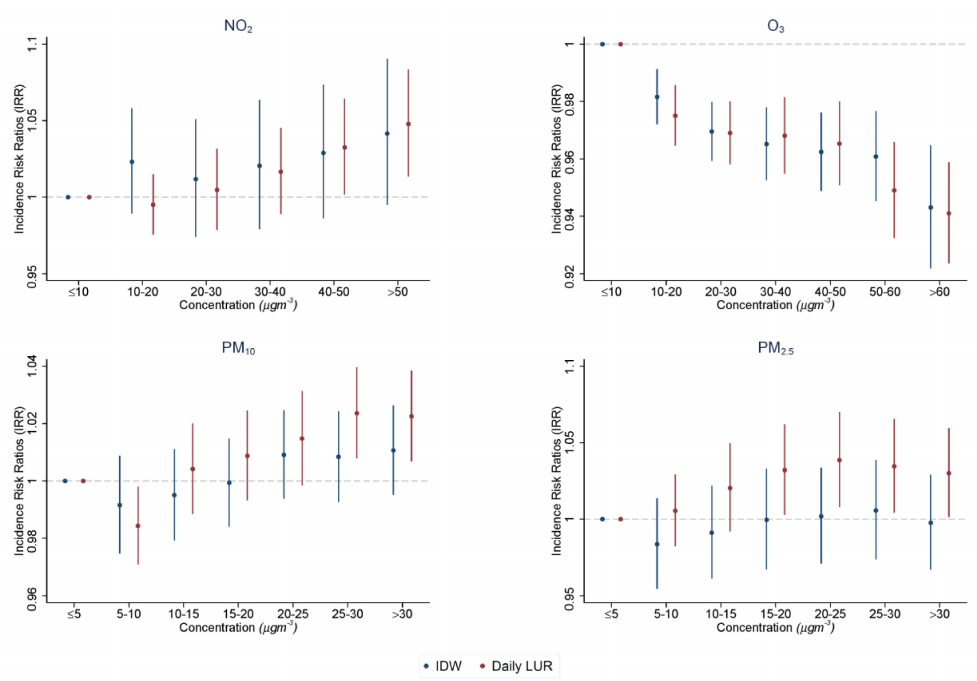
Figure 4. Incidence risk ratios (IRRs) of the effect of exposure on a day in a given range of each pollutant, relative to a day in the reference group. This represents the contemporaneous effect of each pollutant ( β p ). For PM 2.5 and PM 10 , estimates are shown across 5 µgm − 3 bands with a reference group in the 0–5 µgm − 3 range. For NO 2 and O 3 , estimates are shown across 10 µgm − 3 bands with a reference group in the 0–10 µgm − 3 range. Each dot represents the exponent of the point coefficients with 95% CIs reported by the lines on each side of estimates. The results presented are for air pollution exposure assignment through (a) IDW and (b) daily